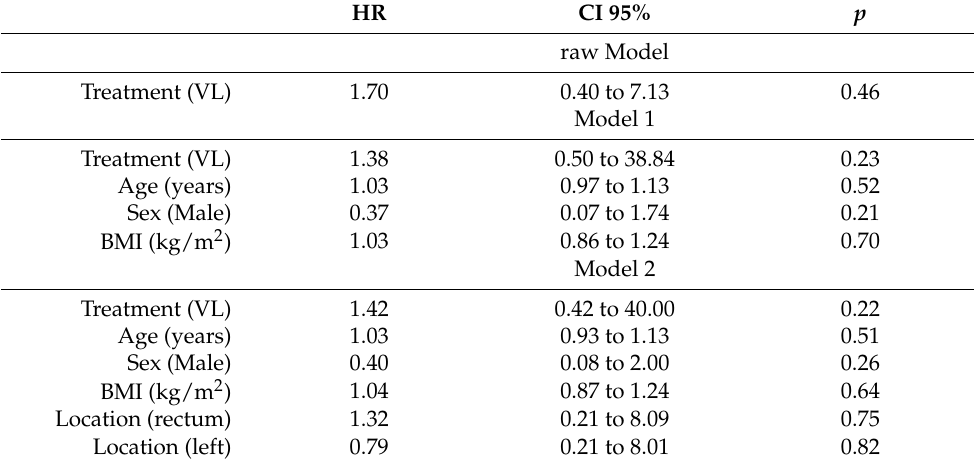
Table 4. Cox regression analysis on tumor